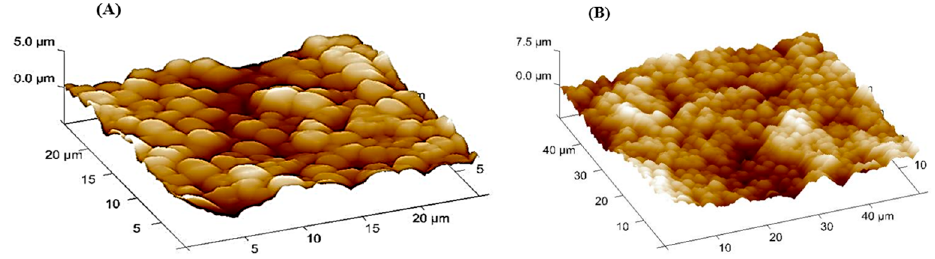
Figure 3. Three-dimensional (3D) surface topography of a bare screen-printed gold electrode (SPGE) using AFM at ( A ) 25 mu and ( B ) 50 mu.